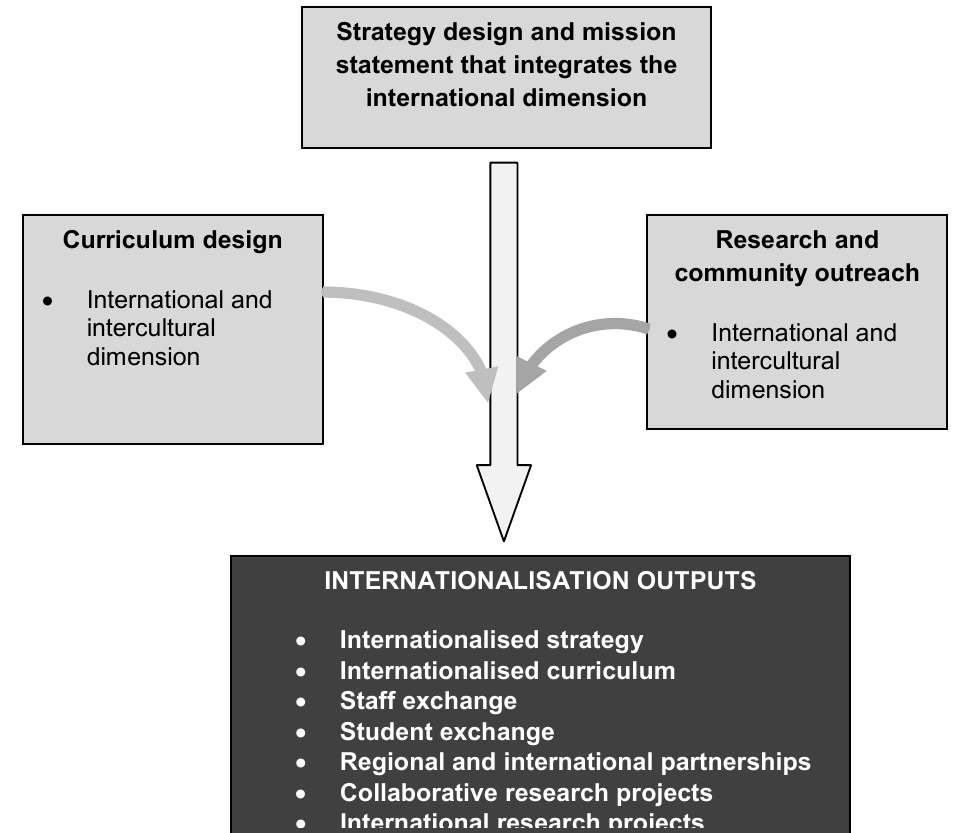
Figure 3 . Internationalisation: activities and